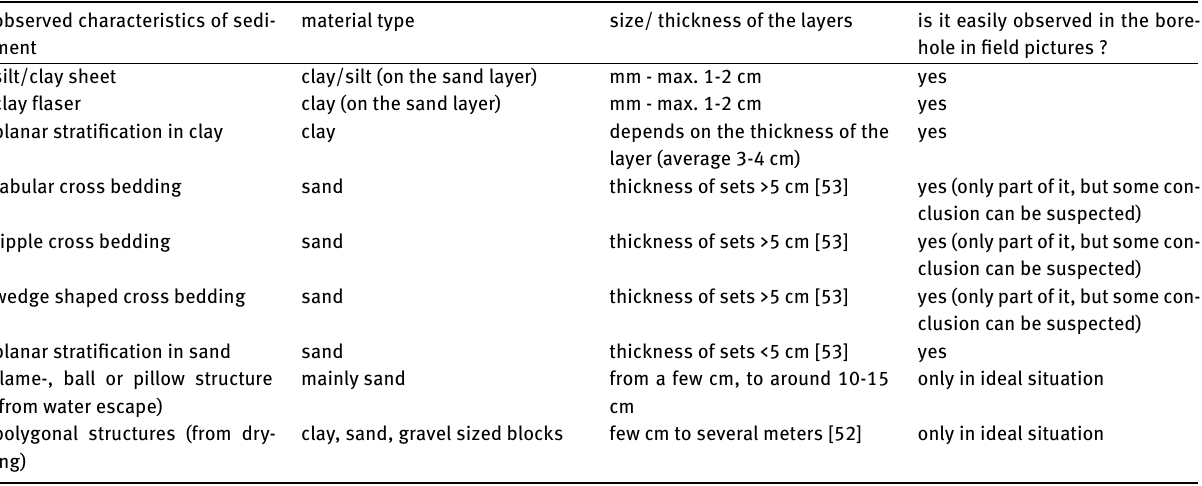
Table 6. Characteristics of the typical sedimentary structures: material type, size of the layers and the fact could they be observed in the field pictures from the borehole. The “ideal situation” means the identification is possible however the conditions that allow (size an configuration of grains, colour and albedo differences, size and direction of shadows from illumination that support the data acquisition etc.) it are probably